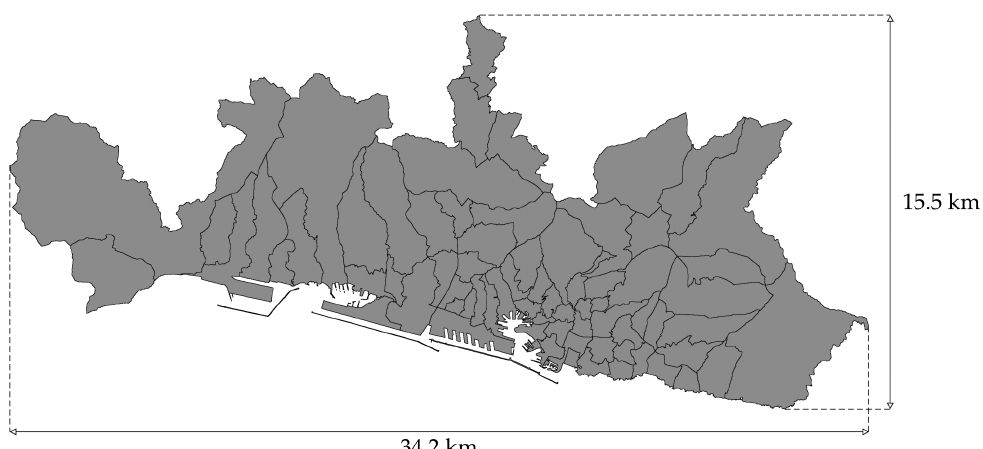
Figure 2. Map of the 71 zones in which the territory of Genoa is divided for the purpose of transport analysis.